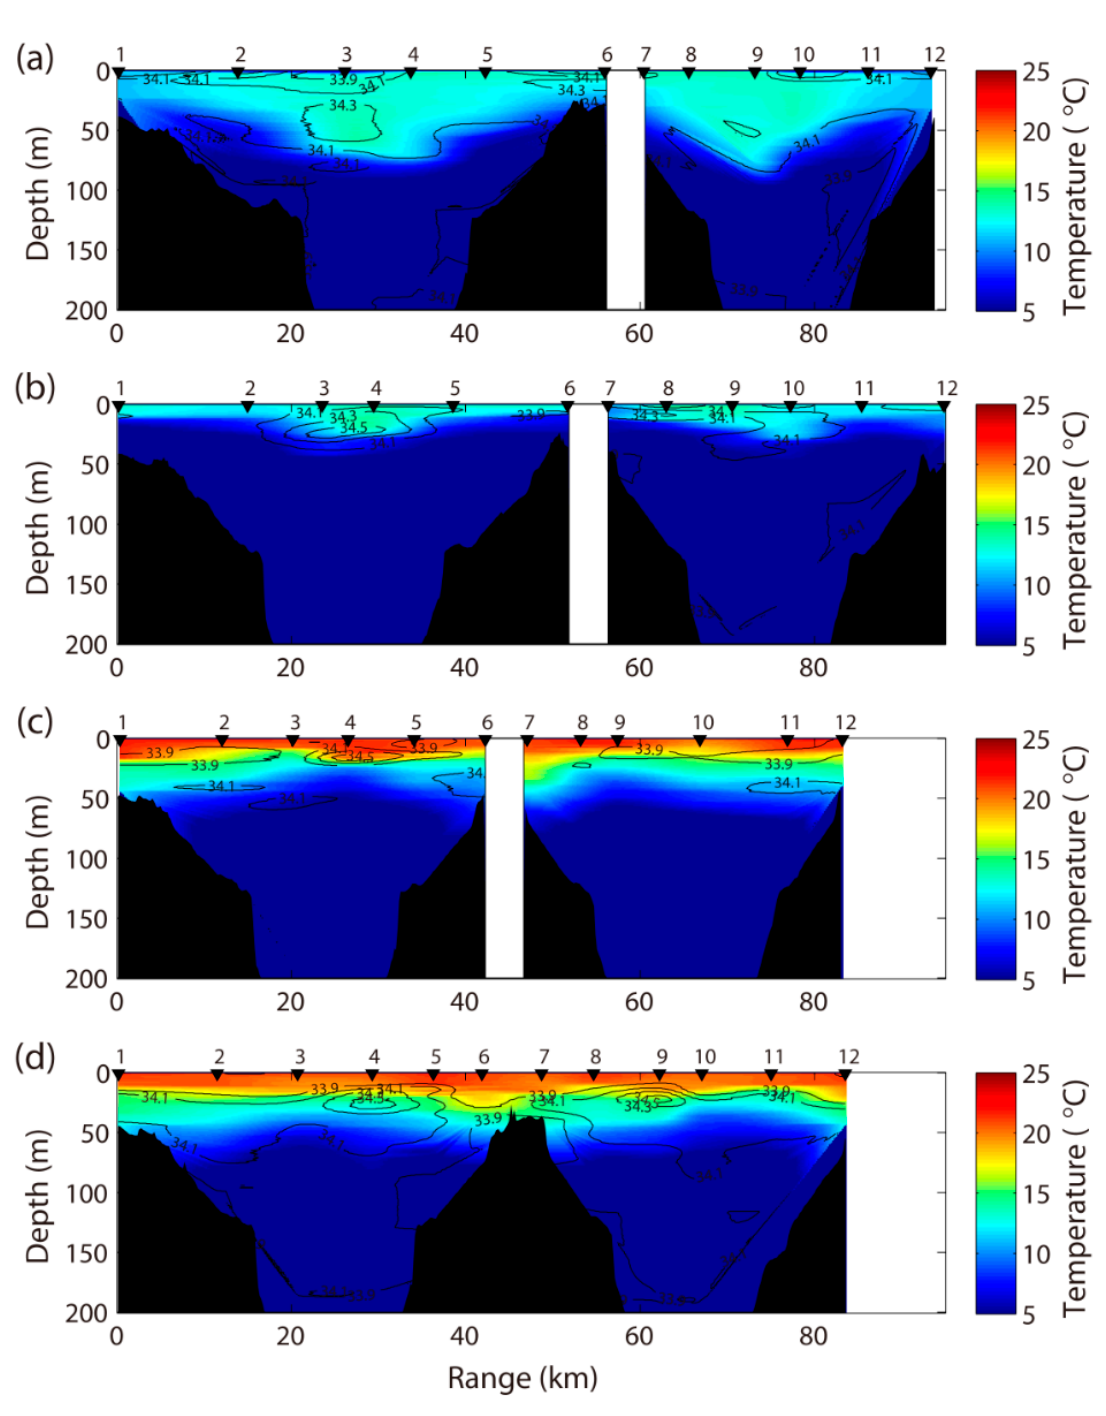
Figure 2. Vertical section of water temperature (°C, color shading) and salinity (contour line) from April to July 2010 in the coastal southwestern East Sea. April ( a ); May ( b ); June ( c ); July ( d ). The 8-day Chl a distribution from the MODIS data from April to July 2010 were av- eraged (Figure 3). The biggest phytoplankton biomass was detected during April. After April, the primary productivity rapidly decreased in the offshore region, and was rela- tively slow in the coastal regions during summer. In May, the Chl a was detected near the southern acoustic transect of the survey area. The bloom rapidly declined between May and July. In summer, the Chl a concentration was low in the East Sea because of the strong stratification in the upper mixed layer (<10–20 m) [29].